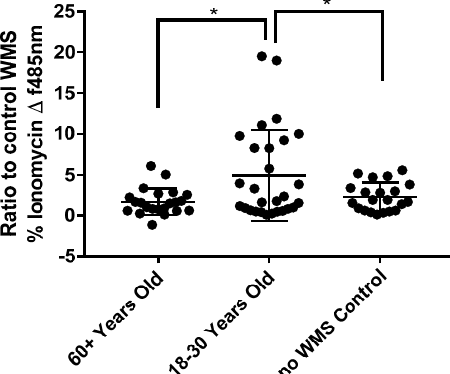
Figure 6. FLEX station measurement of intracellular calcium with caffeine in SCC090 cells with and without UWS from older and younger adults. SCC090 cells were loaded with the fluo-4am calcium indicator and incubated with or without UWS from older (60 + years, n = 22) and younger (18–30 years, n = 28) adults. Fluorescence emissions were recorded using FLEX station fluorescence plate reader, before and after addition of 0.16 mM caffeine. Mean (+/ ₋ SEM) change ( ∆ ) in fluorescence from baseline after compound addition (normalised to ionomycin response and control WS response). Cells stimulated with 0.16 mM caffeine without WS used for comparison ( n = 21). Analysed for statistical significance using independent student’s t test. Significance = p < 0.05 * p < 0.01 ** p < 0.001 ***.